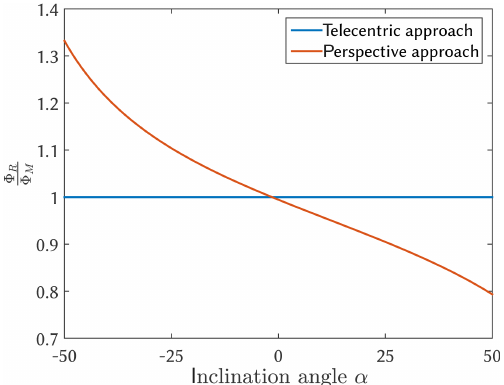
Figure 4. Combined deviations of the three variables of the flux determination for the right half of the image of an SO 2 camera with an FOV angle of 24 ◦